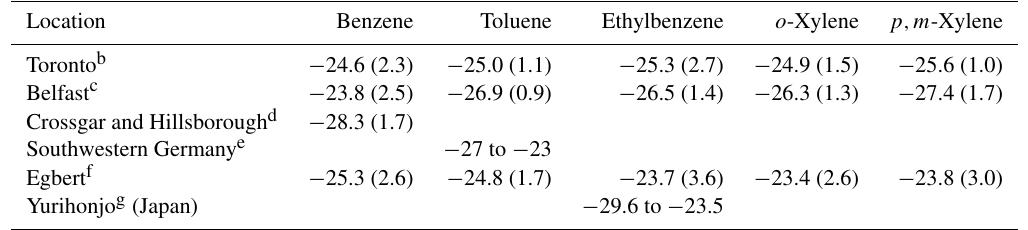
Table 7. Average and standard deviation of reported stable carbon isotope composition measurements ( δ 13 C, ‰) of ambient light aromatic VOC a .